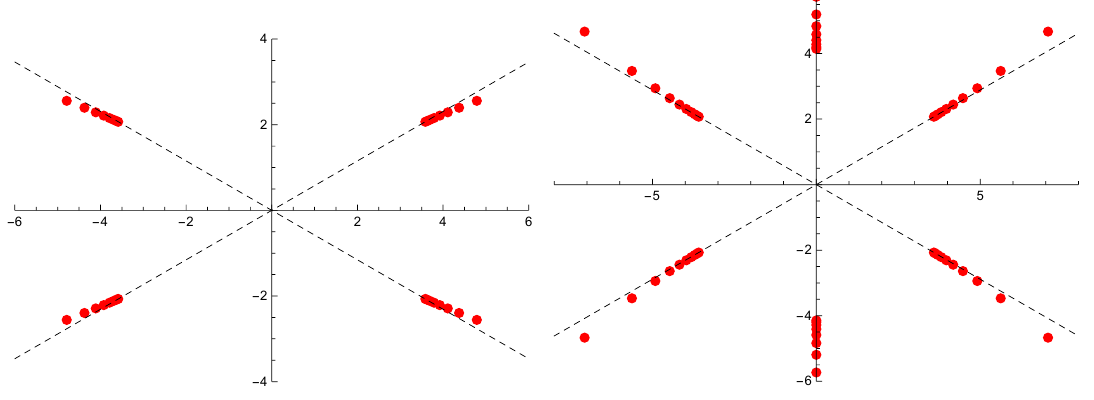
Figure 9 . The singularity structure of the Borel transforms of (cid:5) PT-symmetric pure cubic oscillator (4.20) can be approximated numerically by using Borel-Pad(cid:19)e techniques, and it reproduces the discontinuities of the TBA equations. The diagonal rays are at the angles (cid:25)= (cid:6)